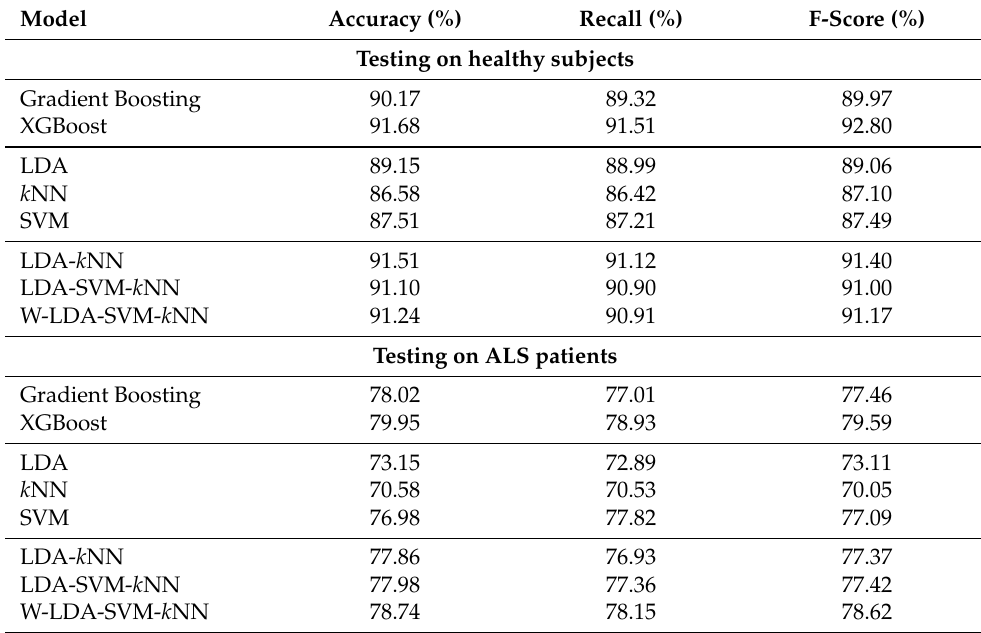
Table 5. Test results using Pz channel